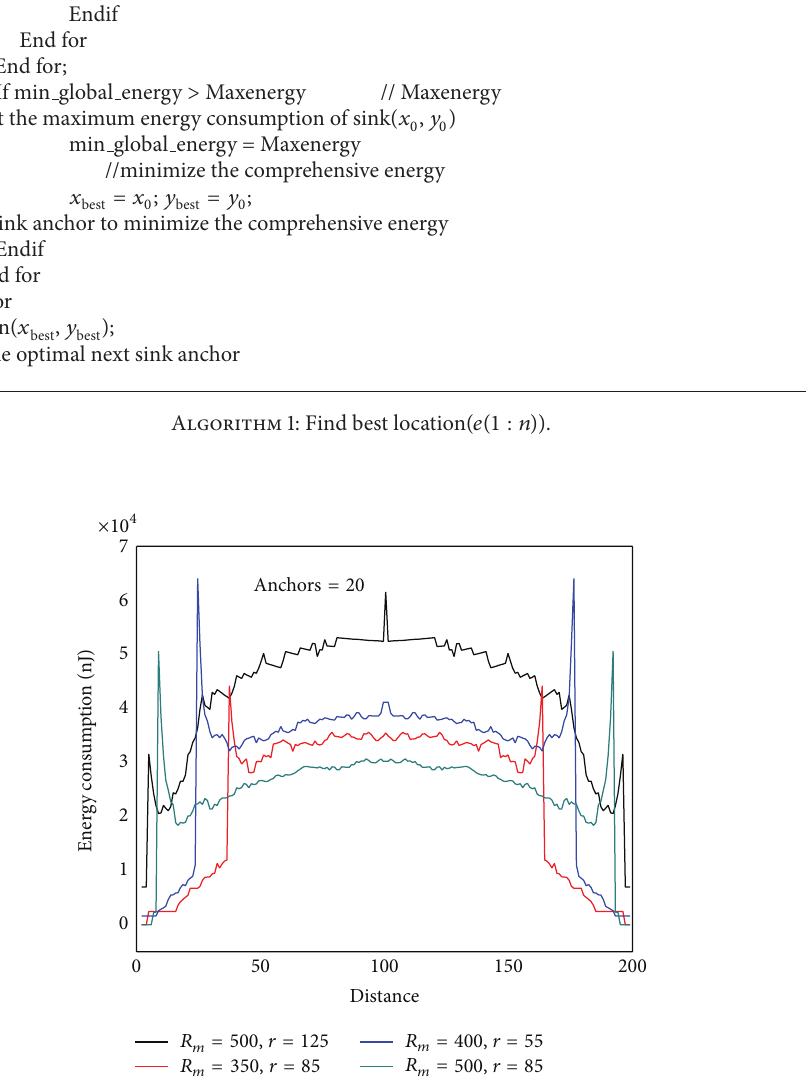
Figure 32: Energy consumption after combining 𝑟 and 𝑅 𝑚 (theoretical